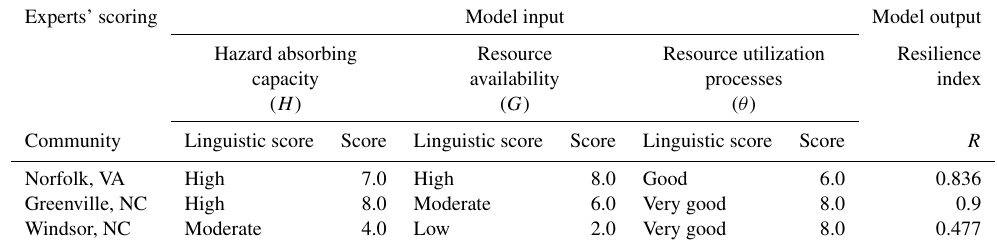
Table 6. Input scoring and R-FIS resilience index